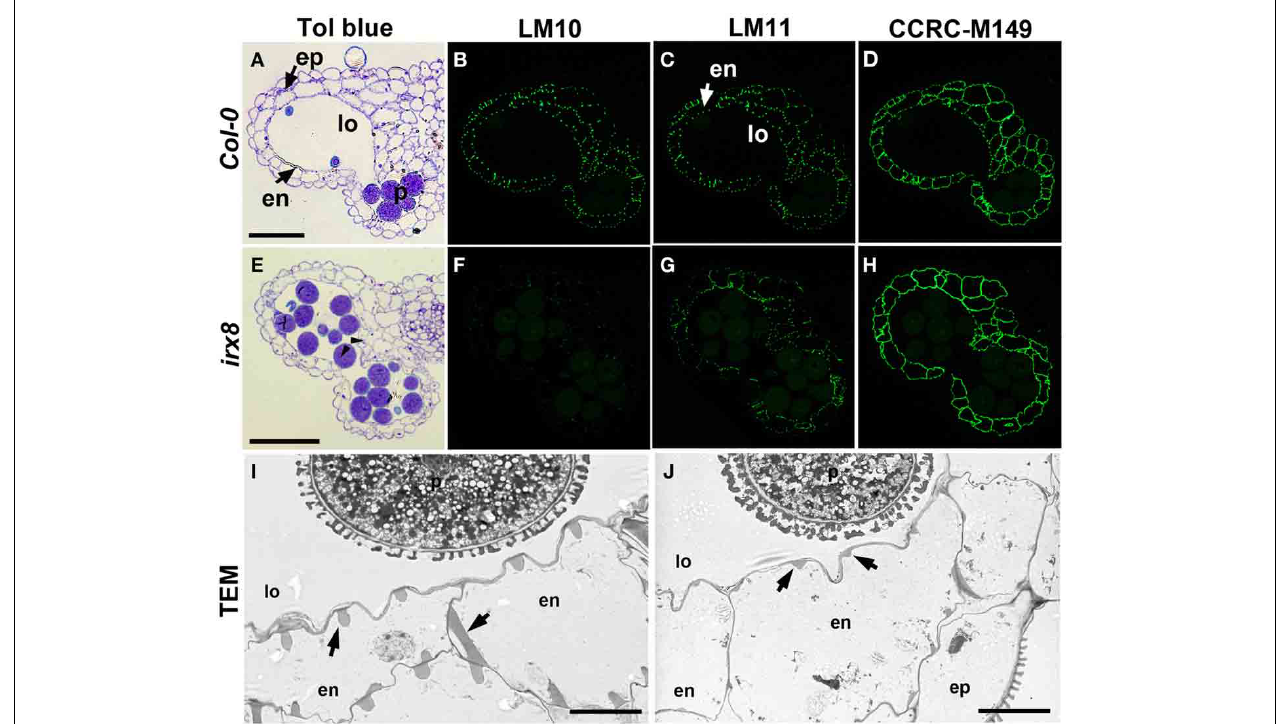
FIGURE 2 | Reduction in xylan deposition in anther endothecium cells in irx8 mutants. LR White-embedded WT (A) and irx8-5 (E) anther transverse sections (250nm-thick) stained with toluidine blue O (Tol blue), arrowheads point to septum breakage. WT (B–D) and irx8 (F–H) anthers immunolabeled with xylan-reactive antibodies LM10